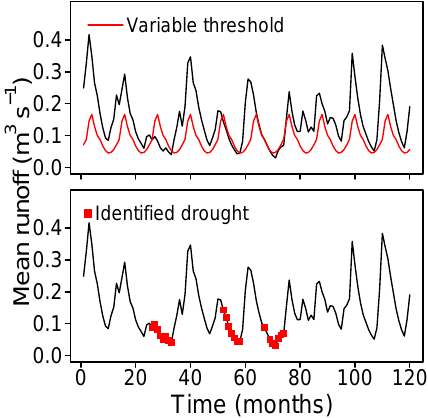
Fig. 4. Example of the variable threshold level method (TLM) to identify droughts for monthly runoff data. Based on the runoff time series (black line), for each individual month m , a threshold Q threshold (red line) is calculated (here taken as the 20th percentile). Months with runoff Q ≤ Q threshold are in a drought (red